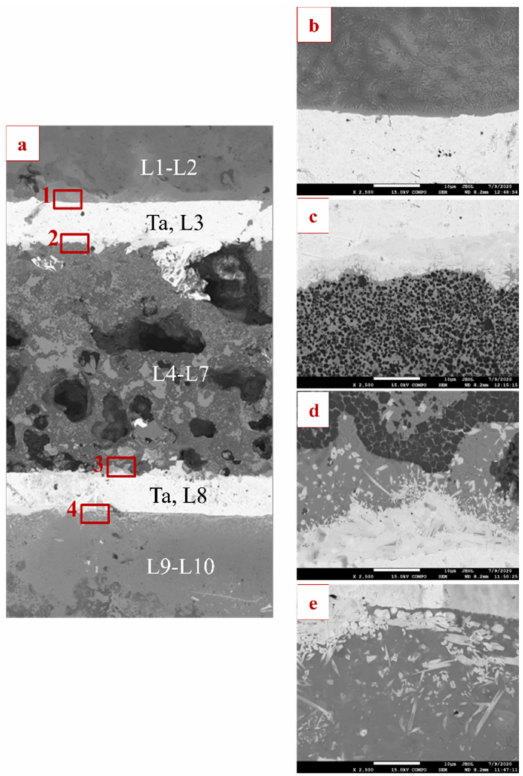
Figure 5. Microstructure of interlayer boundaries formed in cross section of burned Set 1 : ( a ) a general view, ( b ) Ti–Ta interface at (L1–L2)–L3, ( c ) Ta–cermet interface at L3–(L4–L6), ( d ) (Ni + TiB x )–Ta